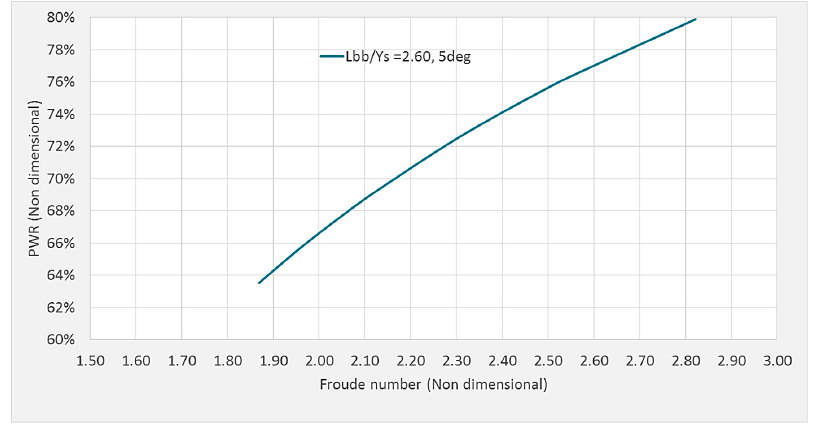
Figure 25. Proposed PWR approximation using normalized bulb length, 5 ˚ pitch angle, L bb = 0.974 ′ , Y s = 0.375 ′ .